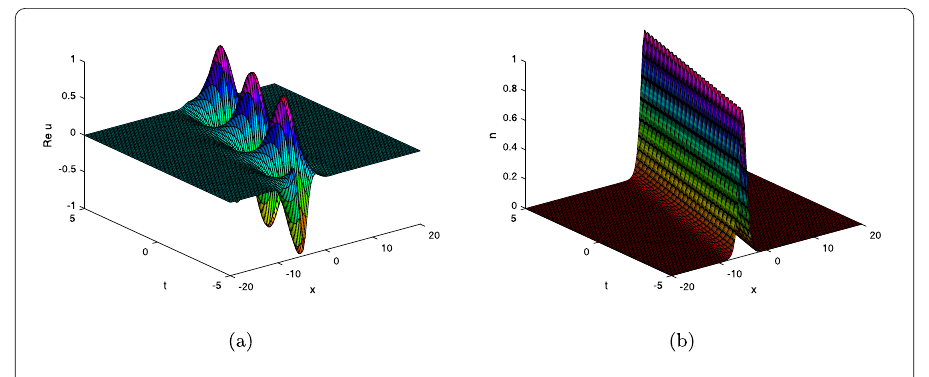
Figure 1 Bright soliton with B =